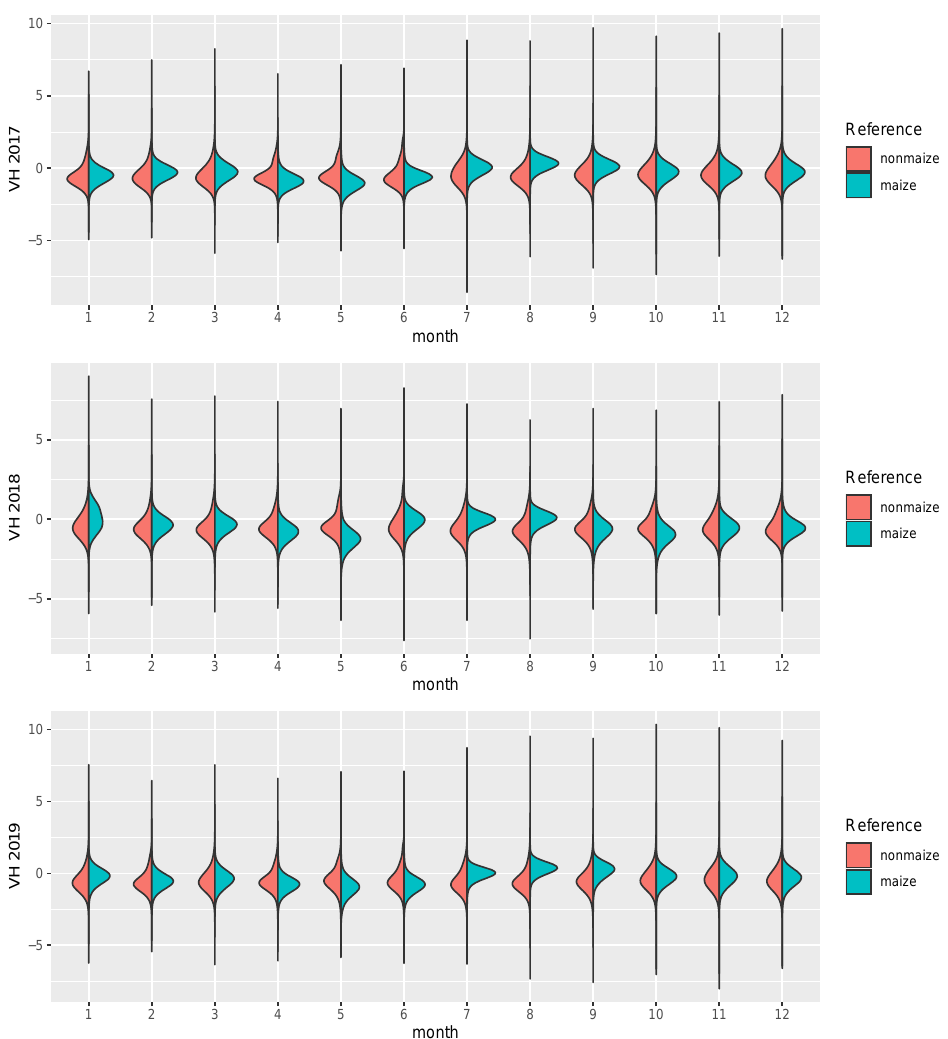
Figure 3. The figure shows distribution density estimates of the 12 monthly means for 4 years, split by maize (turquoise) and nonmaize (red)